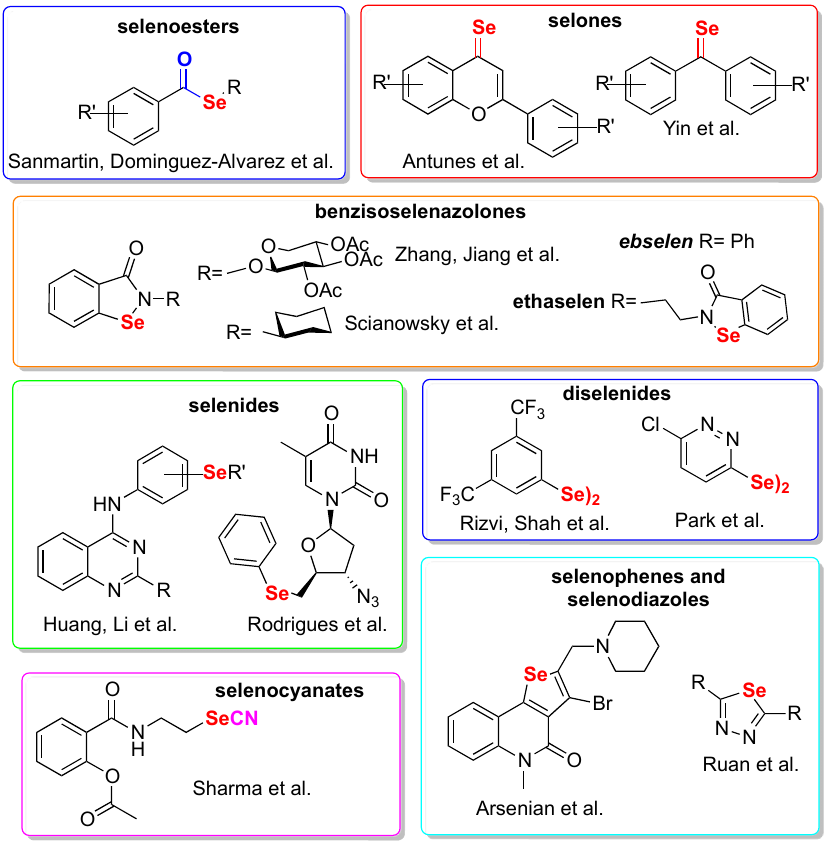
Figure 1. Selection of Se-containing compounds preclinically profiled as anti-neoplastic agents.